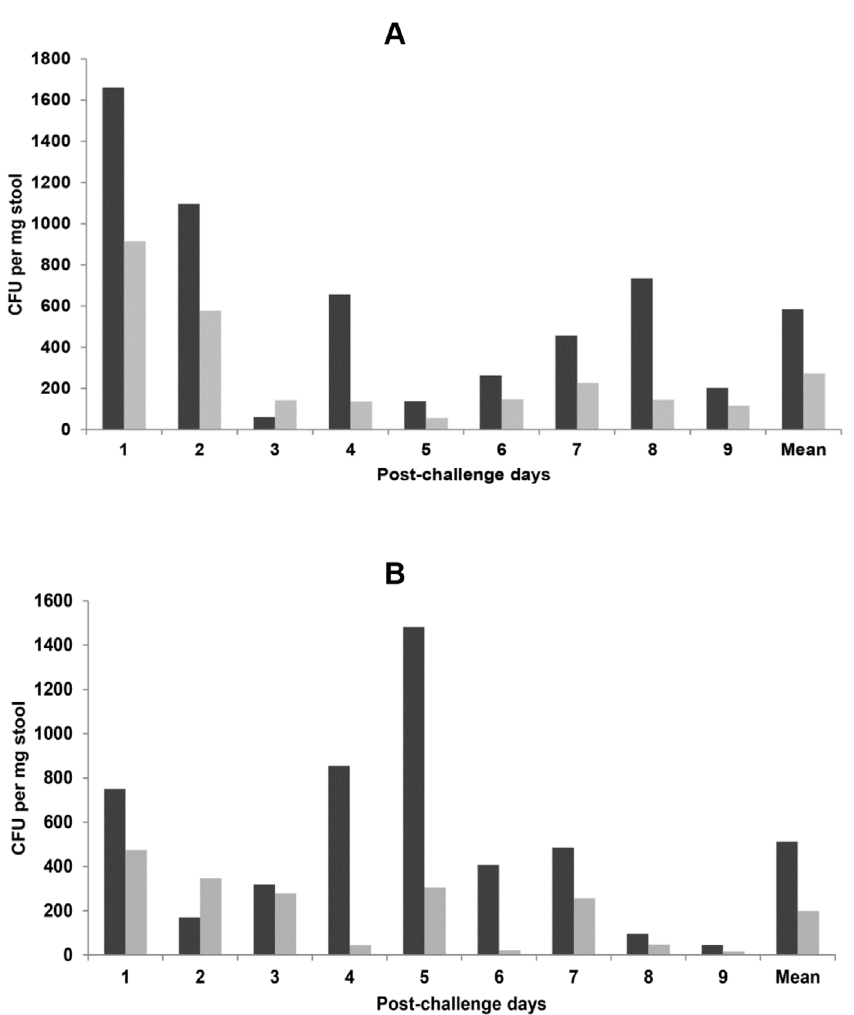
Fig 3. Fecal excretion by mice of C . jejuni 48 (A) and C . jejuni 111 (B). The X-axes represent post- challenge days and the Y-axes show the number of bacteria excreted per mg feces. “ Mean ” is the mean for all 9 days. Reduced excretion by the vaccinated mice (light bar) compared with the control mice (dark bar) was not statistically significant for any day or mean excretion for C . jejuni 48, but significant for days 4 and 6 ( P = 0.008 for both days) for C . jejuni